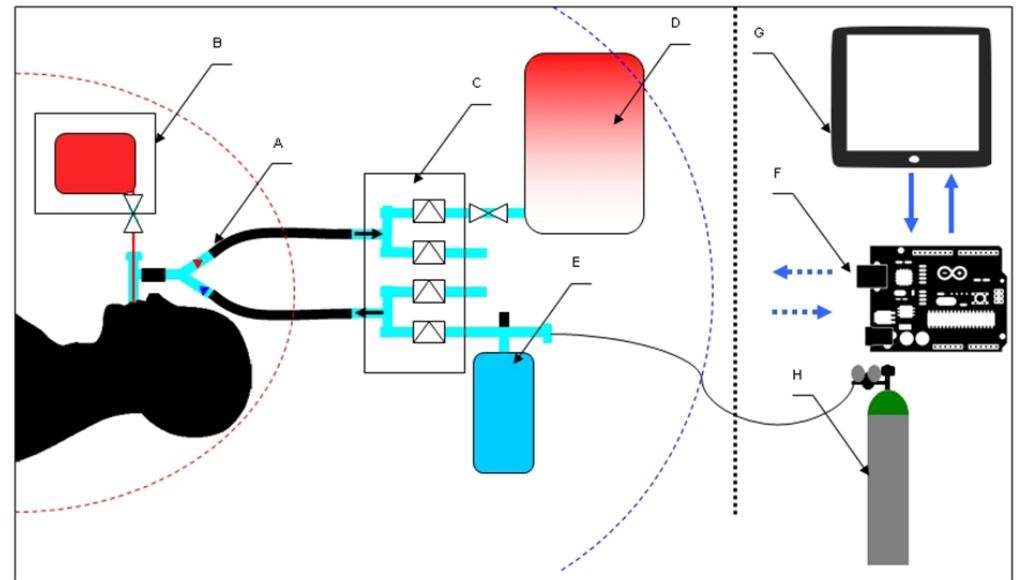
Figure 1. Ventilator setup. The red, blue and black dashed lines indicate the area of high magnetic field of the medical scanner magnet, 0.5 mT stray field limits, and the area outside the Faraday cage, respectively: A —three-way junction, B —Tedlar bag with HP 3 He inside the pressure chamber, C —system of pneumatically controlled gas valves, D —helium tight metalized bag for the exhaled gas collection, E —nitrogen reservoir for lungs flushing, F —electronic control module for pneumatic valves, G —computer with the LabView program for ventilator control, H —high pressure nitrogen bottle.